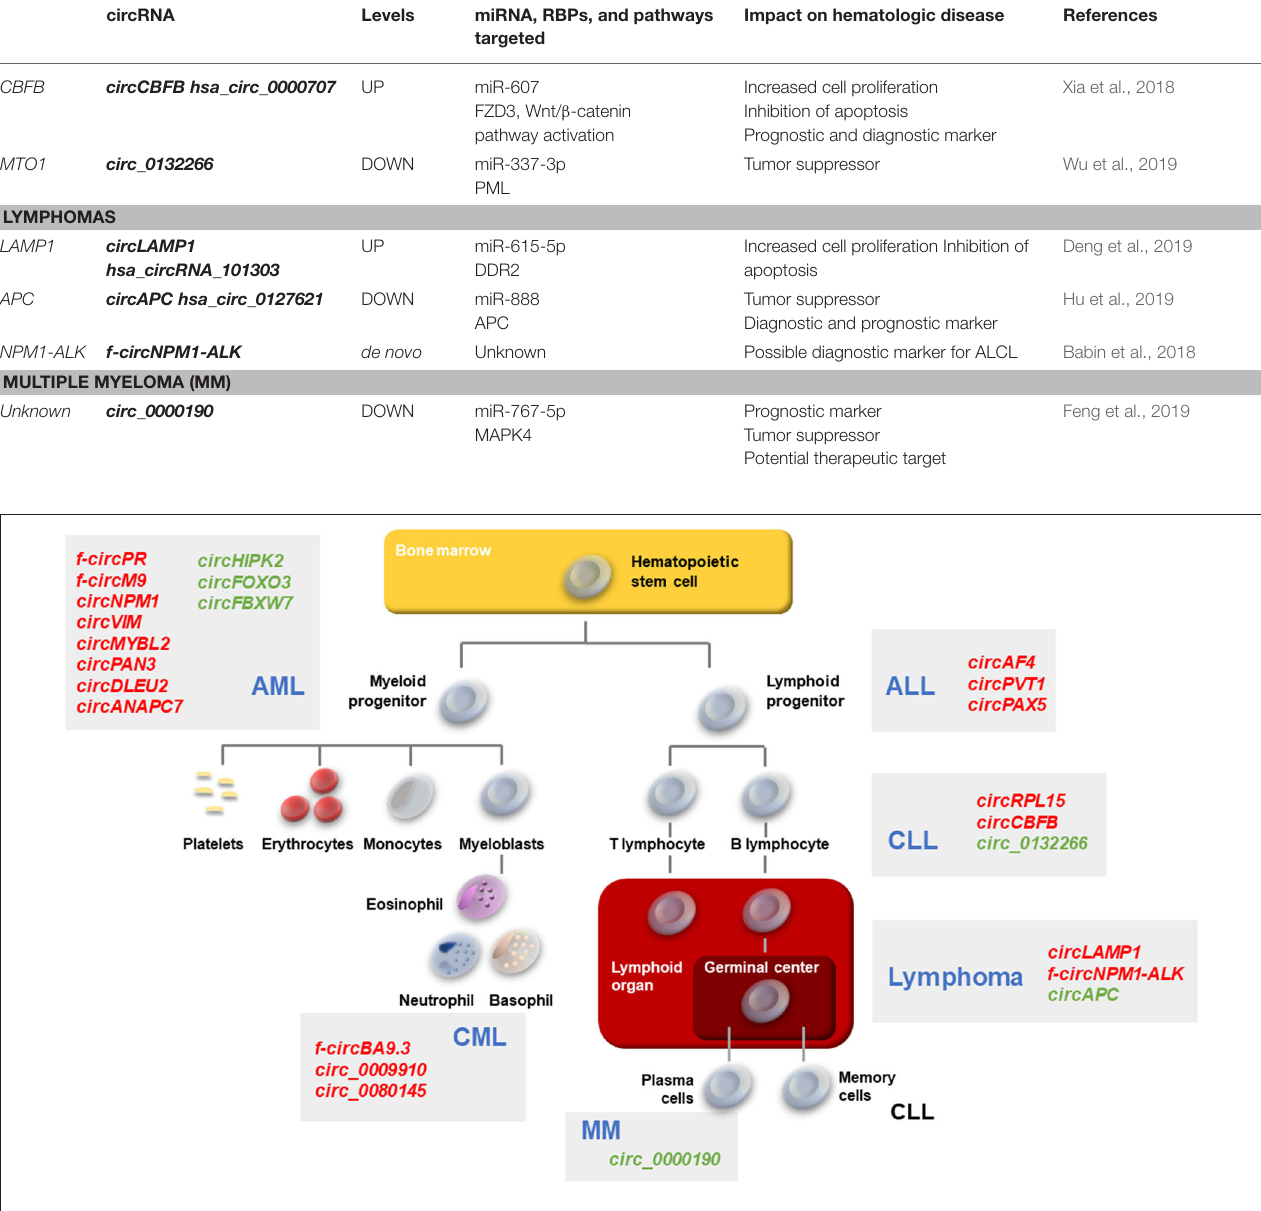
FIGURE 1 | Schematic of hematopoiesis depicting the developmental cell types giving rise to the major leukemias and lymphomas. AML, CML, ALL, CLL, Lymphomas, and MM described in the text are represented. Gray boxes, the main circRNAs associated with each malignancy are indicated in red (upregulated in malignancy) or green (downregulated in